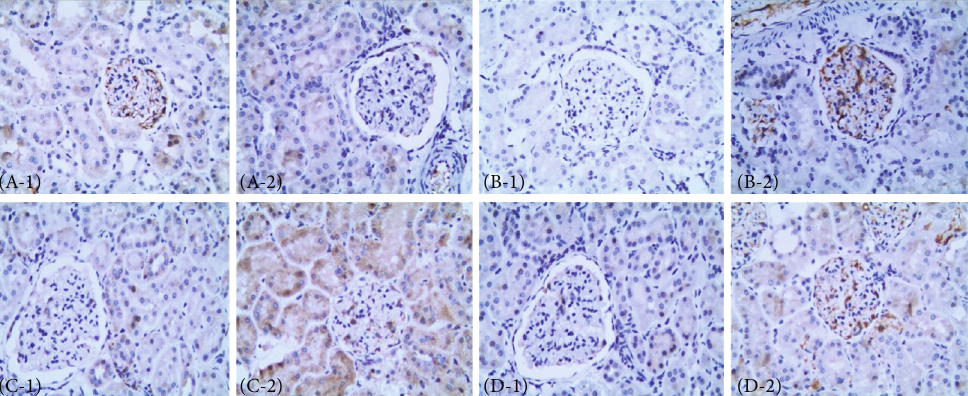
Figure 9: Immunohistochemical detection of SIRT, HIF-1a, Egr-1, and TGF- β 1 in the kidney ( × 400). (a – d) SIRT1, hypoxia-inducible factor-1 α (HIF-1a), early growth response-1 (Egr-1), and transforming growth factor- β 1 (TGF- β 1), respectively; 1 and 2 represent the DN+LRG and control groups, respectively. Control: diabetic nephropathy group; DN+LRG: diabetic nephropathy+liraglutide group. ∗ P < 0 : 05 vs. the control.